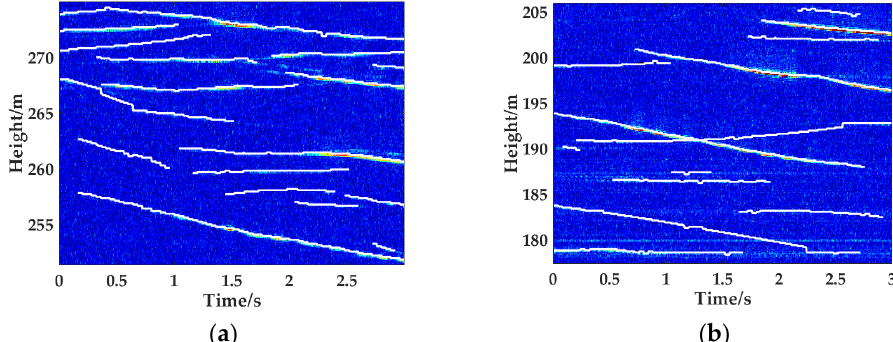
Figure 4. ( a , b ) Two typical HRRPs and the detected flight tracks by the high-resolution coherent VLR.